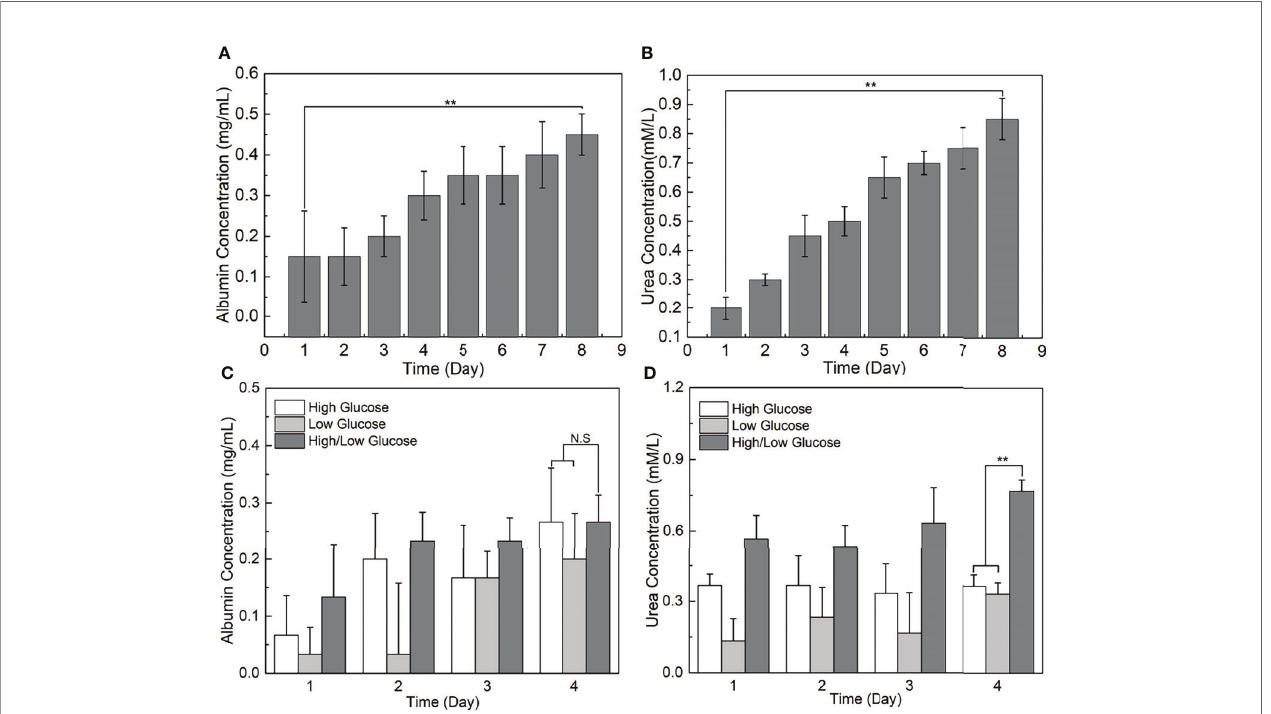
FIGURE 6 | Liver-speci fi c metabolite concentrations as a function of time. (A) The change of albumin concentration in the medium over time; (B) The change of urea concentration in the medium over time; (C) The effect of glucose concentration gradients on the albumin synthesis of HCs; (D) The effect of glucose concentration gradients on the urea metabolism of HCs. **p <